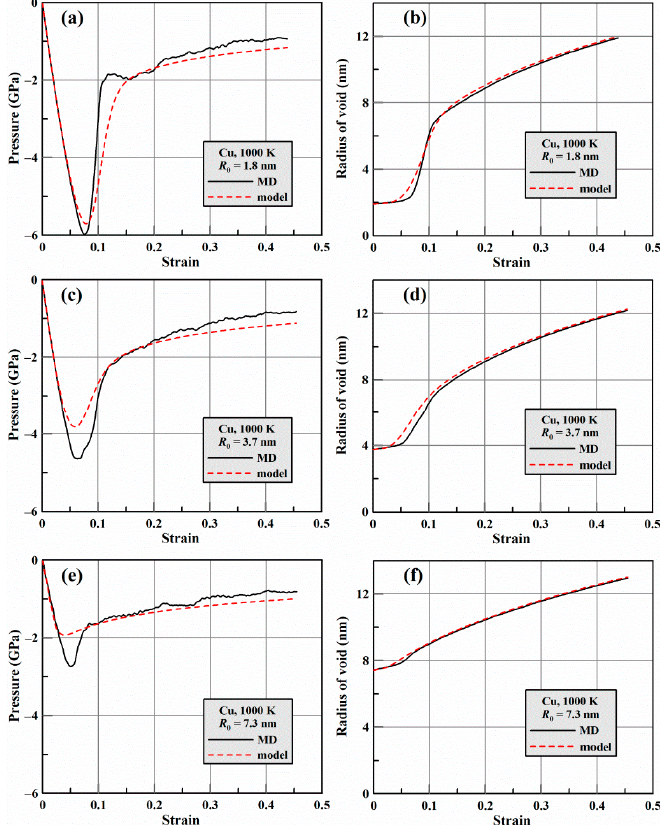
Figure 5. Comparison of the model and MD data for the case of copper at 1000 K with non-wettable